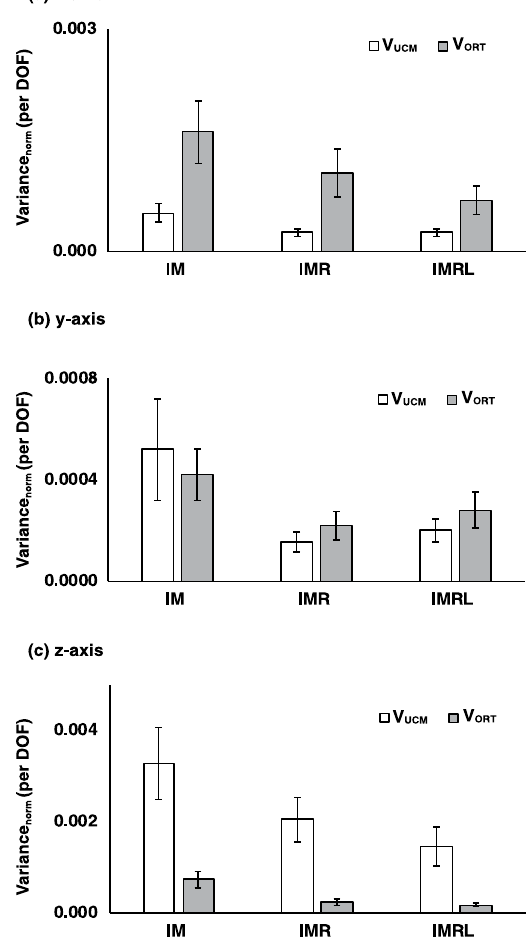
Figure 2. Two components of variances related to F TOT stabilization, V UCM (white bars) and V ORT (gray bars) per degree-of-freedom, in the finger force space are presented for the ( a ) x -axis, ( b ) y -axis, and ( c ) z -axis. Values are means ± standard errors across subjects.